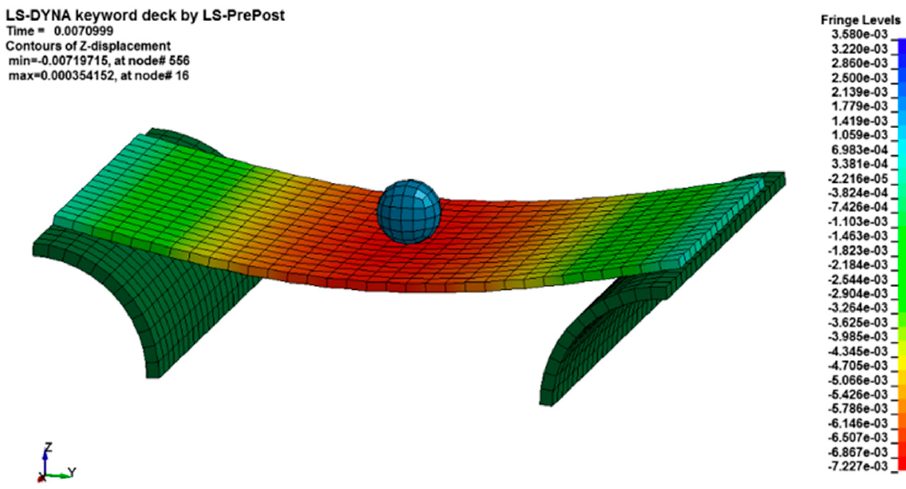
Figure 5. Maximum displacement for the plate during the impact evolution. Table 5. Parametric analysis for sample A.